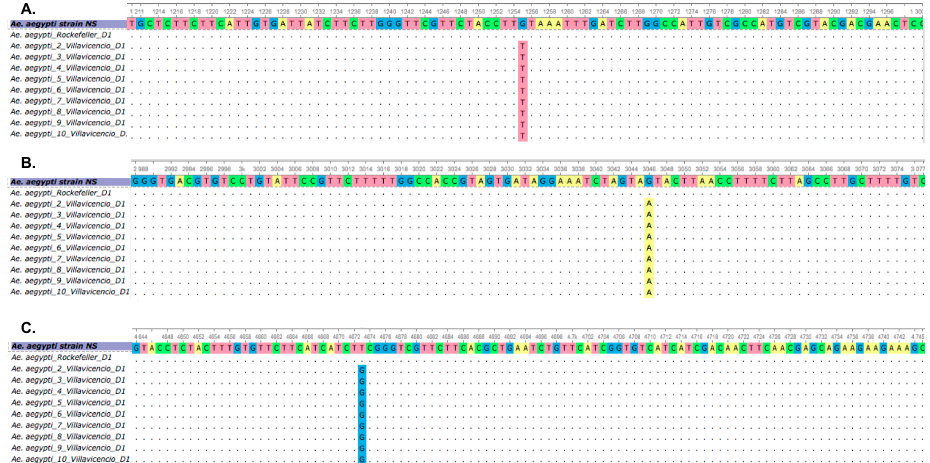
Figure 2. Alignment of cDNA fragments of the DIS4-6 ( A ), DIIS1-6 ( B ) and DIIIS4-6 ( C ) regions of the sodium channel gene obtained for Ae. aegypti from Villavicencio and Rockefeller strain. The sequences were aligned with ClustalW version 1.81. Identical nucleotides are indicated by a dot (.). The sequences were also compared with Ae. aegypti strain NS available from GenBank and one mosquito from Rockefeller strain, susceptible to pyrethroids. The resistant mosquitoes were 100% identical. ( A ): point mutation G1255T (V419L), ( B ): mutation G3046A (V1016I) and ( C ). Mutation T4673G